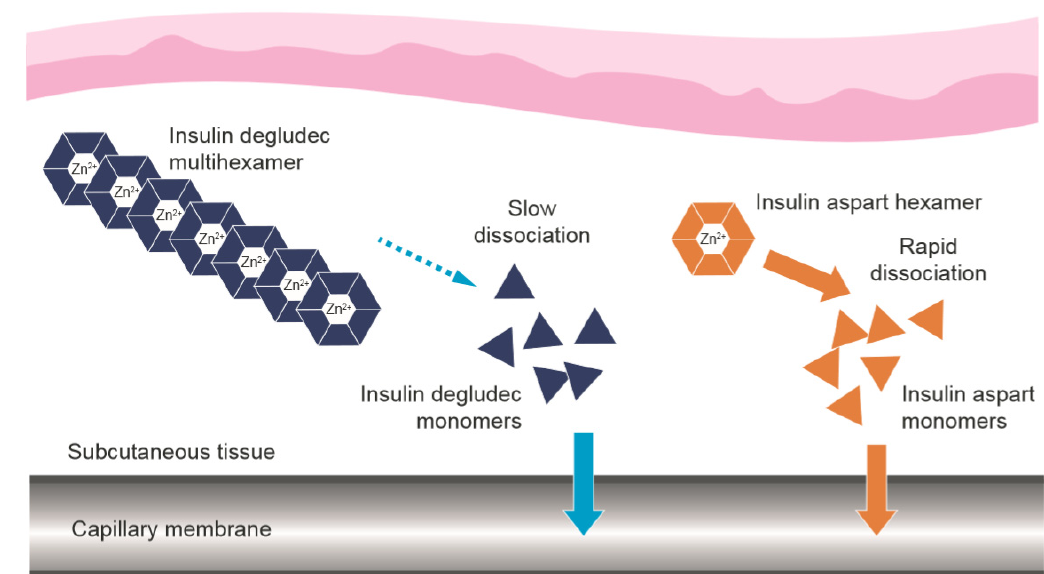
Figure 2. Dissociation of the components of IDegAsp following subcutaneous injection [27]. IDegAsp = insulin degludec/insulin aspart co-formulation. The use of Figure 2 from “Distinct Prandial and Basal Glucose-Lowering Effects of Insulin Degludec/Insulin Aspart (IDegAsp) at Steady State in Subjects with Type 1 Diabetes Mellitus” by Heise, T. et al. (2015) [18] is licensed under CC BY 4.0.